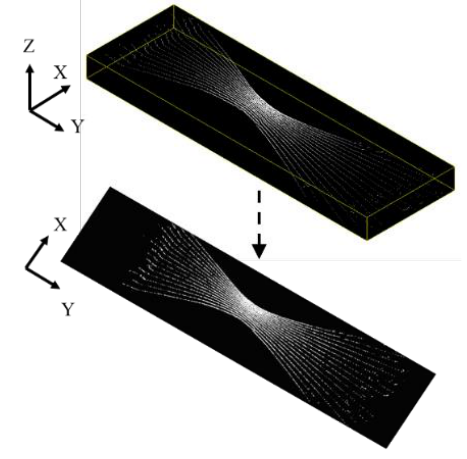
Figure 4. Image Augmentation by